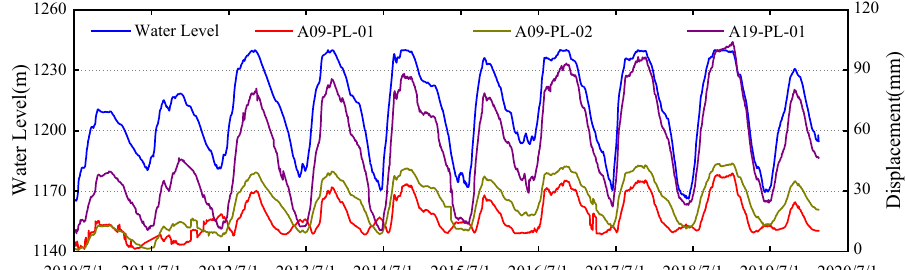
Figure 6. Layout of pendulum monitoring instruments.